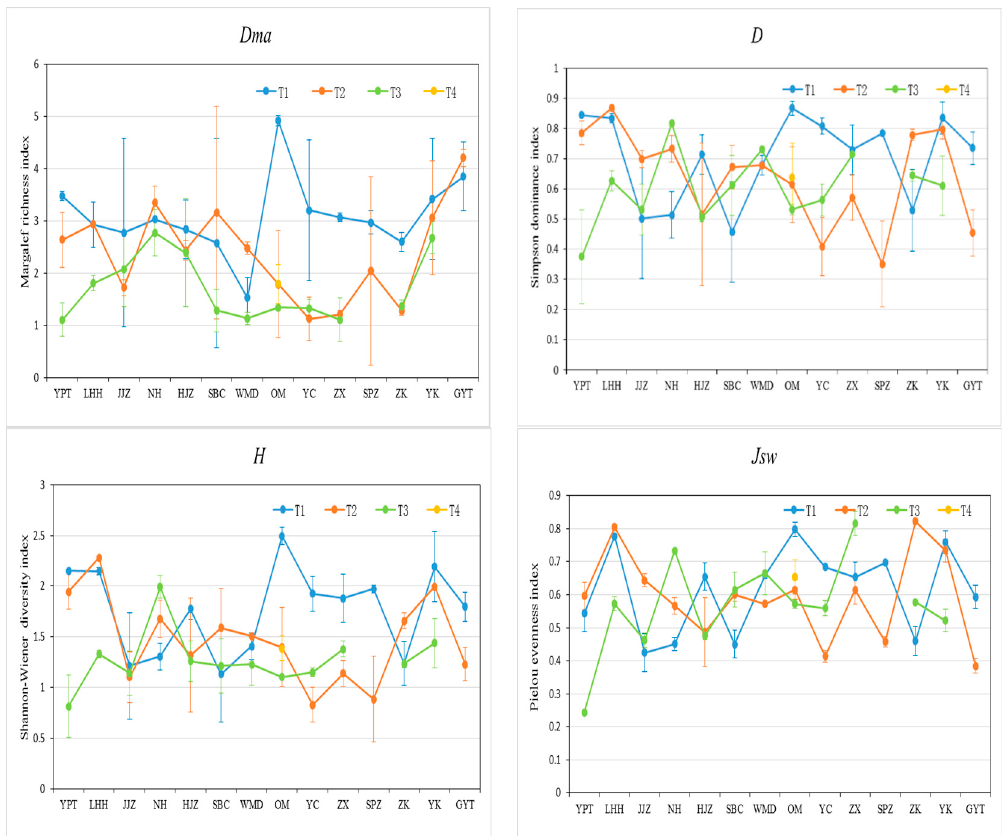
Figure 4. The diversity indices of different transects in the sampling sites in the MLHR, China. Dma, Margalef richness index; D, Simpson dominance diversity index; H, Shannon–Wiener diversity index; and Jsw, Pielou evenness index. T1, 2, 3, and 4 represent the first, second, third, and fourth transect, respectively. YPT, Yangpitan; LHH, Lihuahu; JJZ, Jiangjiazhou; NH, Nanhu; HJZ, Hujiazhou; SBC, Shanbiancun; WMD, Wumingdao; OM, Oumiao; YC, Yicheng; ZX, Zhongxiang; SPZ, Shipaizhen; ZK, Zekou; YK, Yuekou; GYT, Guanyintang. Table 2. Regression coefficient (canonical characteristic coefficient) and sorting summary between edaphic factors and sorting extraction. TN, total nitrogen; TP, total phosphorus; SOM, soil organic matter.